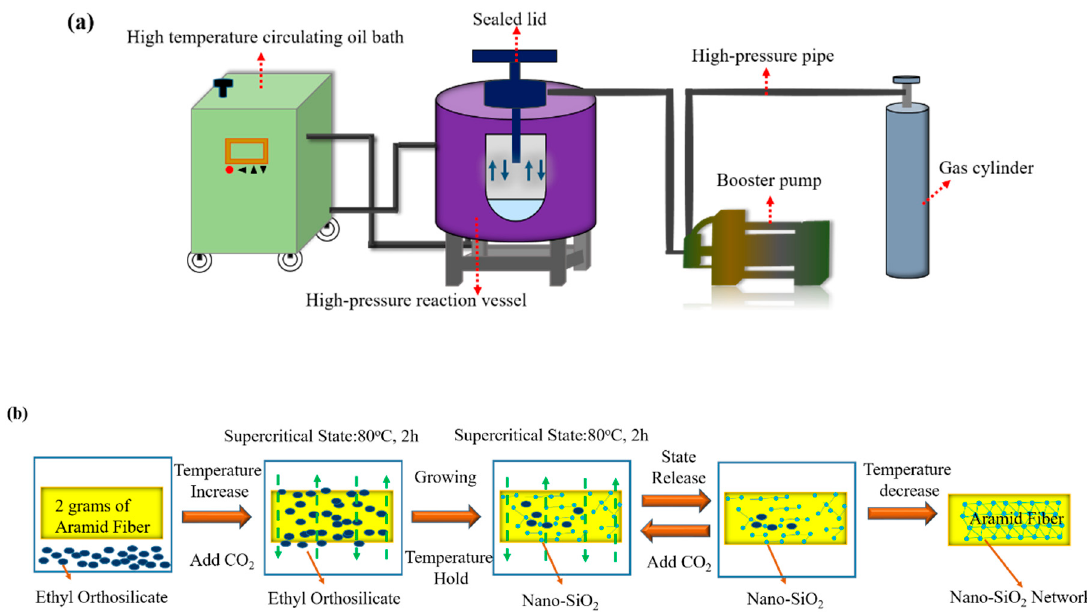
Figure 1. Set of reaction equipment ( a ) and schematic diagram of growing nano-SiO 2 on the fiber surface ( b ).